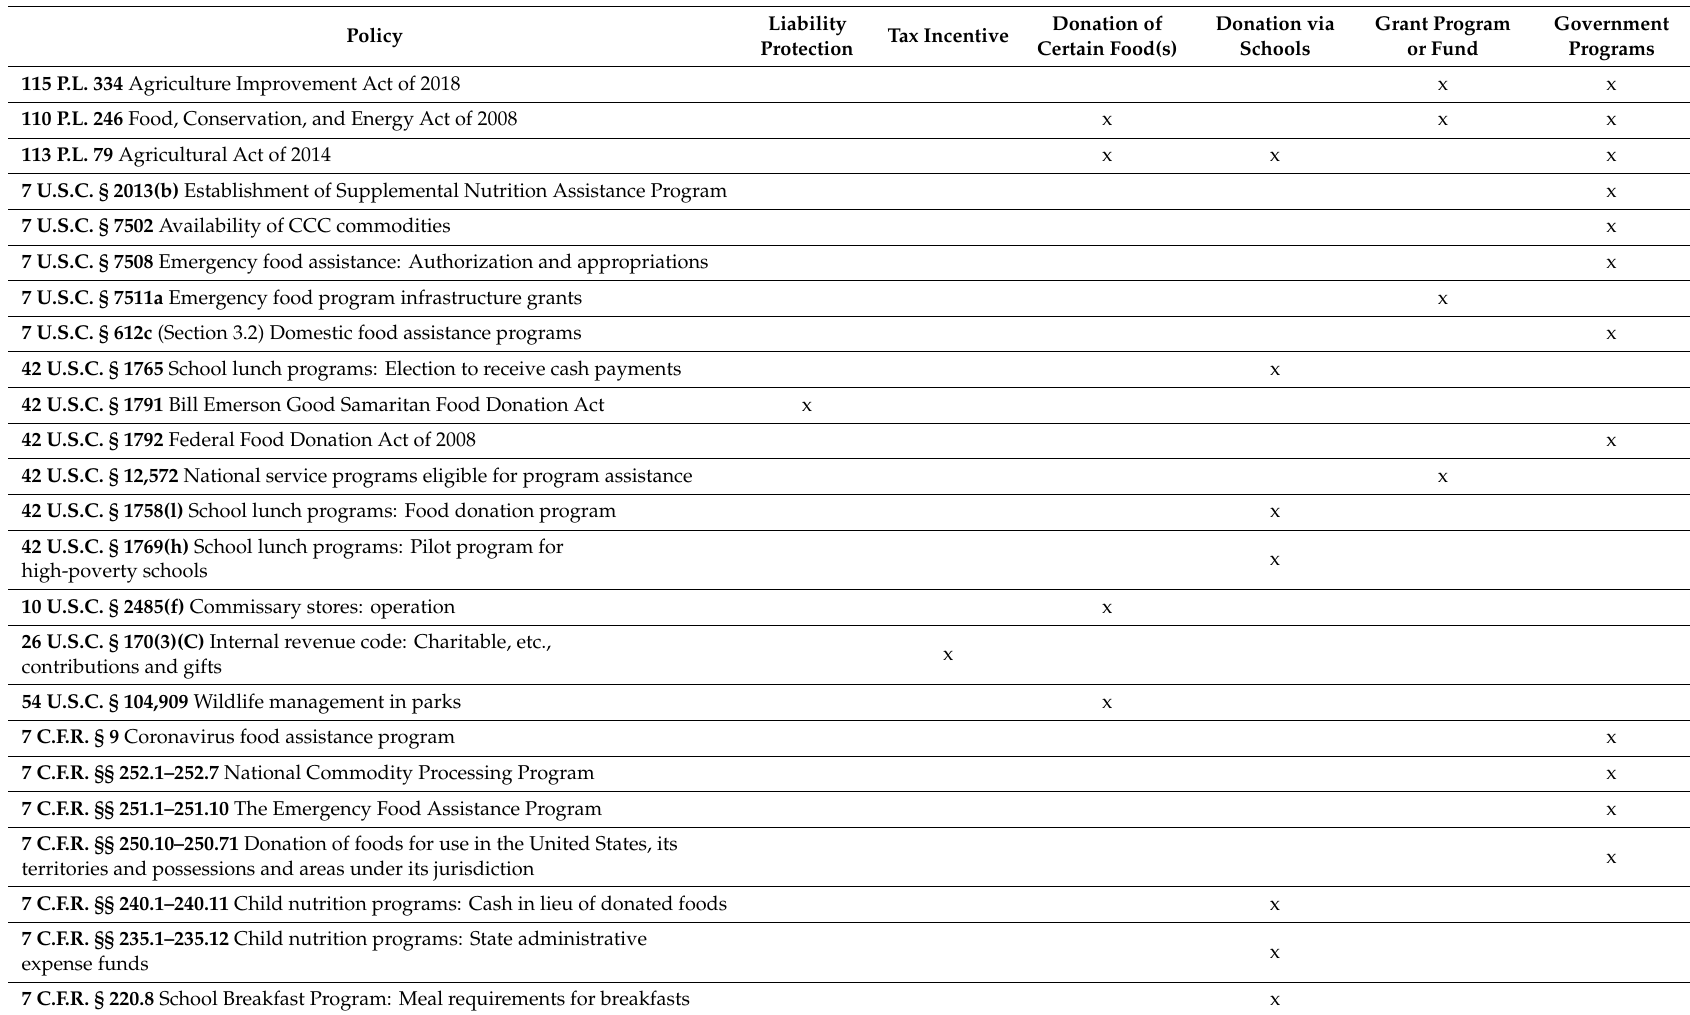
Table 2. Federal policies related to food